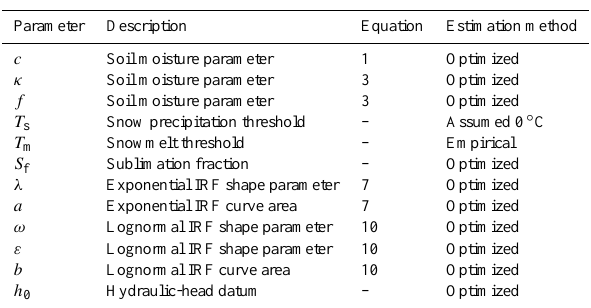
Table 1. Model parameters [–, not